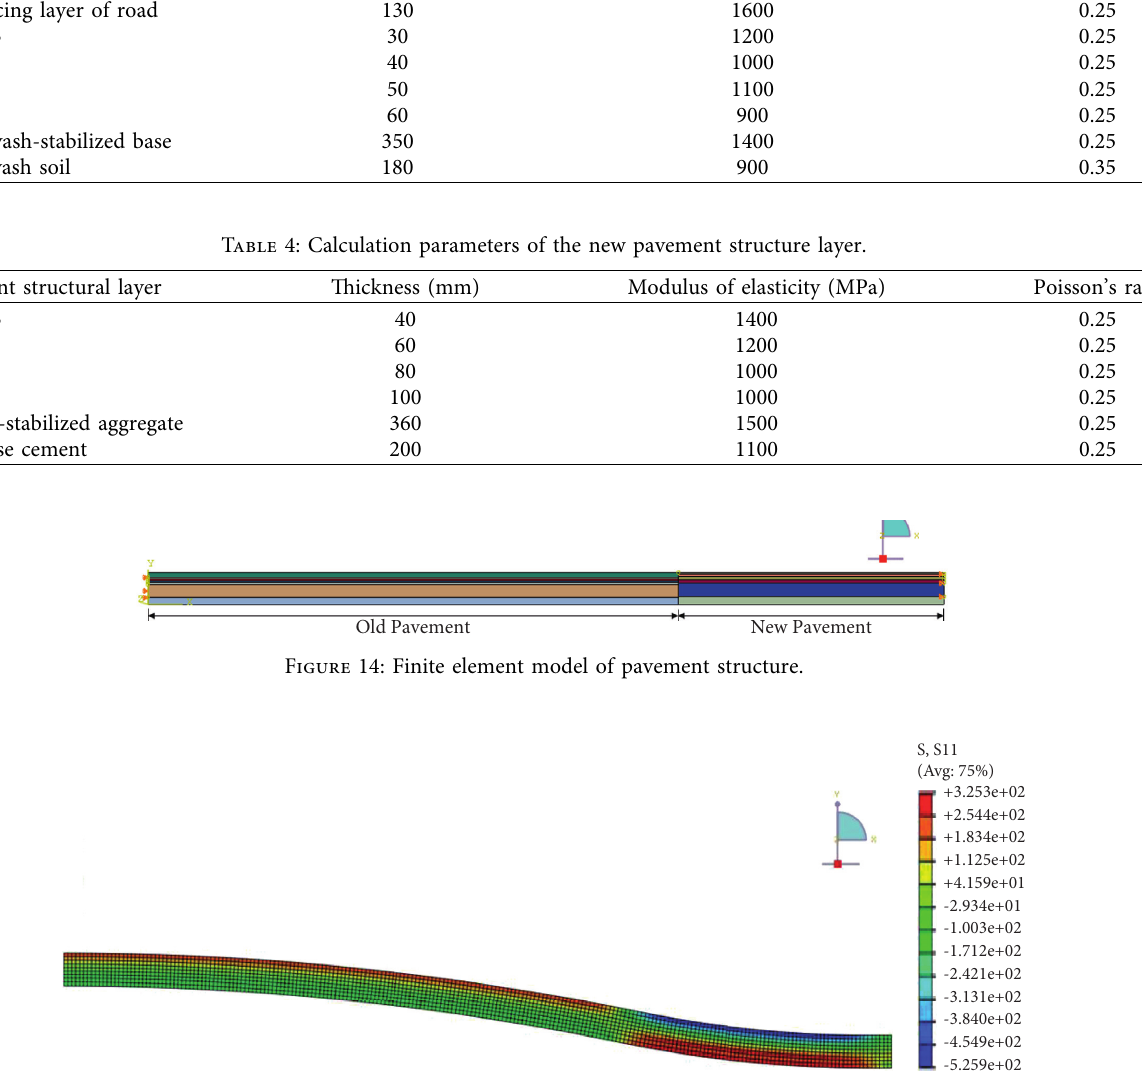
Figure 15: Nephogram of additional stress of pavement structure.